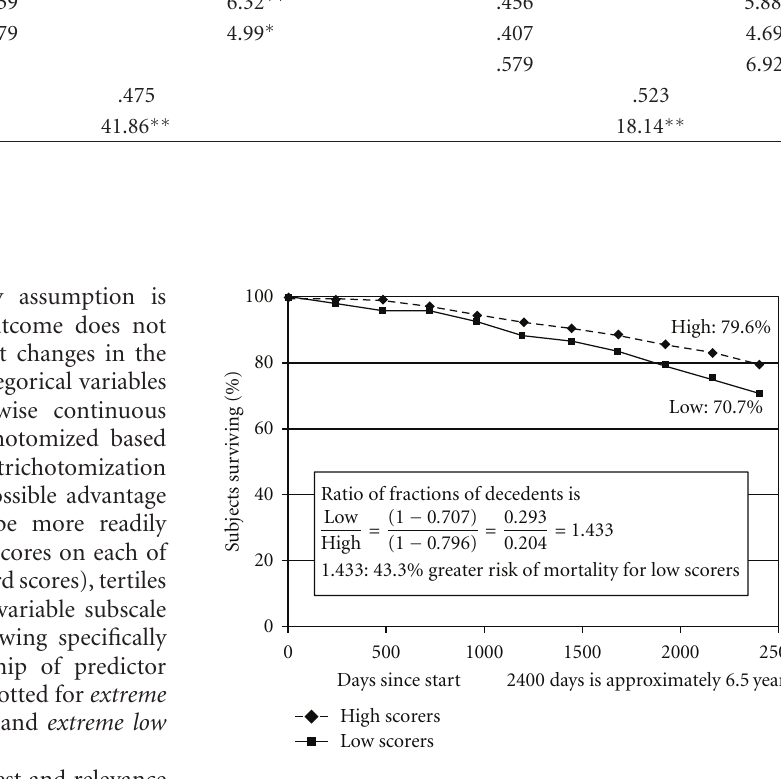
Figure 1: Survival in the groups with high and low scores on BJW ( self ) over approximately 6.5